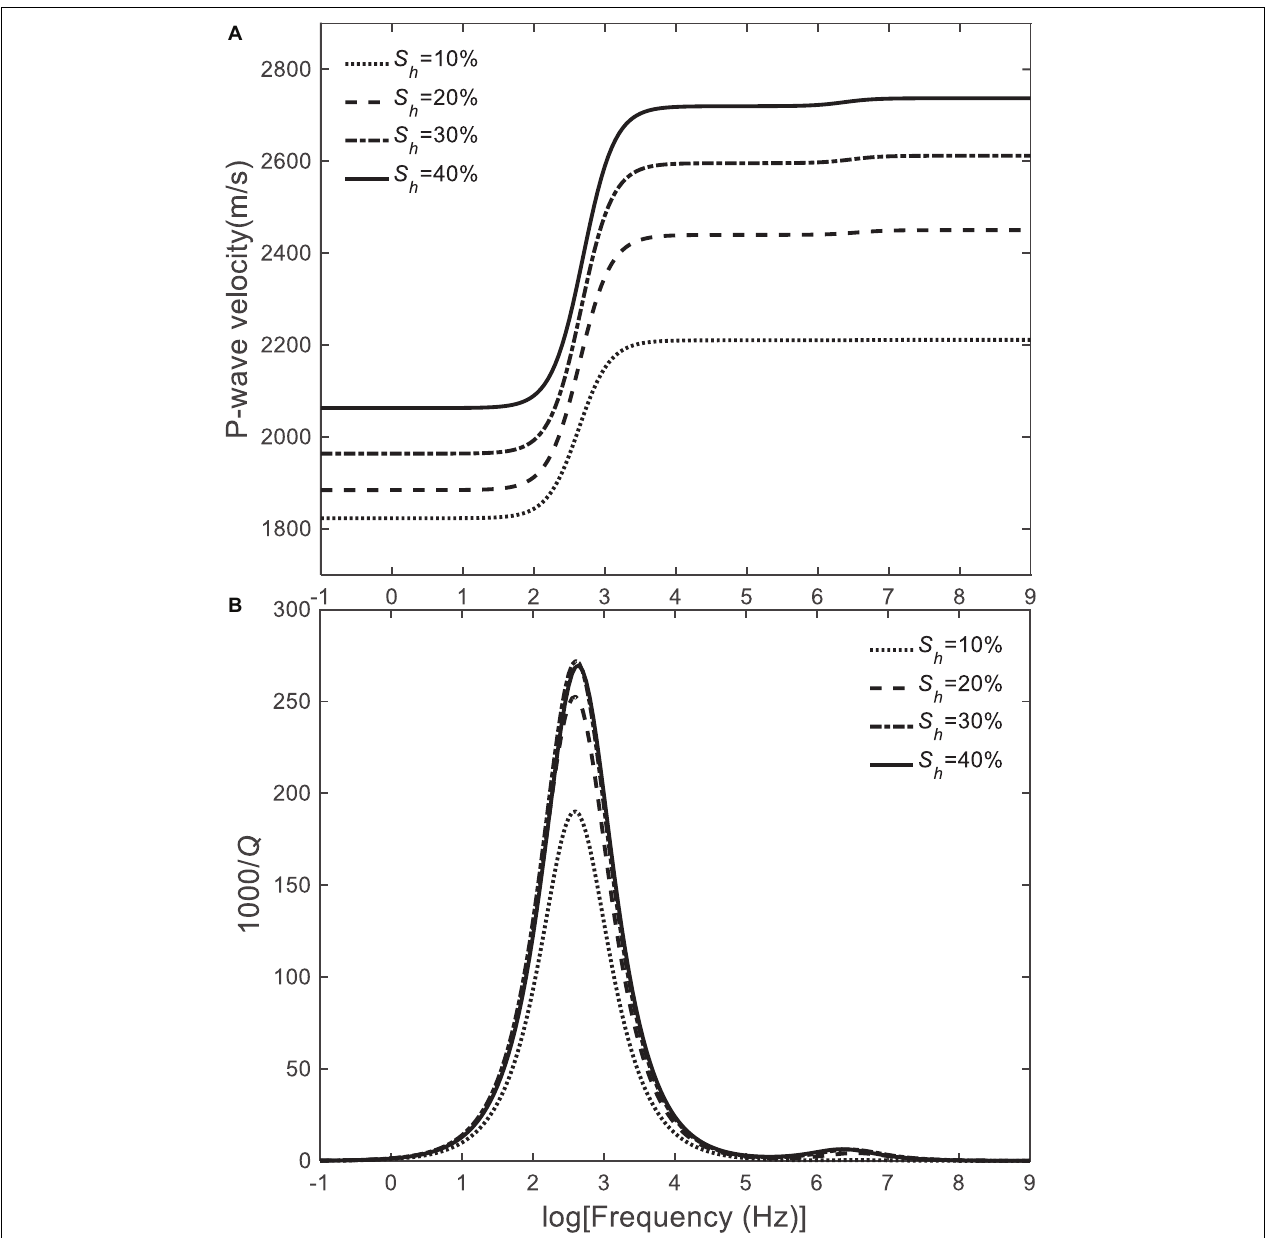
FIGURE 10 | Model 2. P-wave velocity (A) and dissipation factor (B) as a function of frequency for different hydrate contents. The inclusion radius is 1 cm and the porosity is 40%.